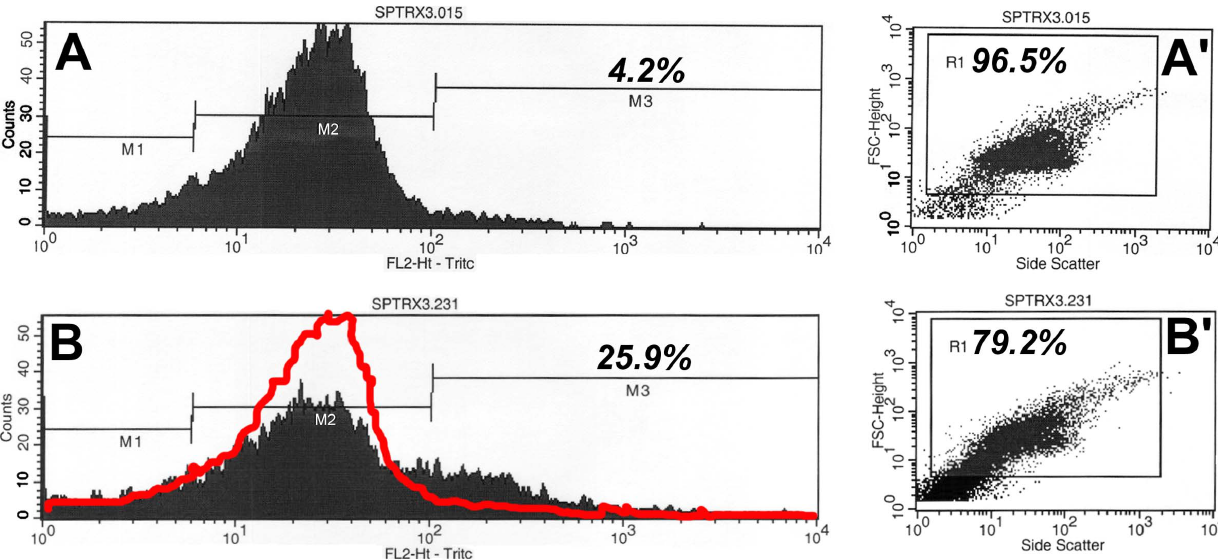
Figure 1. Examples of flow cytometric histograms (A, B) and corresponding light scatter diagrams (A ’ , B ’ ) of two male patients with varied SPTRX 3 levels. Histograms, representative of SPTRX3 fluorescene levels in 10,000 cells/sample are divided into marker areas M1 (low fluorescent spermatozoa, sperm fragments and cellular debris), M2 (mostly intact spermatozoa with background-level fluorescence) and M3 (defective, SPTRX3-positive spermatozoa and immature sperm forms with high fluorescence). Percentage of SPTRX3-positive spermatozoa out of total sperm content, including markers M1, M2, and M3 is shown. Gate R1 in scatter diagrams of visible light separates spermatozoa (each dot is one cell) from other flow cytometric events; resultant percentage is percent of high/low fluorescent spermatozoa from total number of flow cytometric events measured per sample in order to acquire 10,000 measurements. Sample B was donated by a patient previously diagnosed with male infertility (oligo-astheno-teratozoospermia; 5 million sperm/ml, 30% motility, 22% normal morphology). Flat histogram-curve and a secondary peak within marker area M3 coincide with 25.9% of SPTRX3–positive spermatozoa in this sample. Sample A was donated by a presumably fertile man with acceptable clinical semen parameters (80 million/ml, 50% motility, 74% normal morphology) whose female partner suffered from